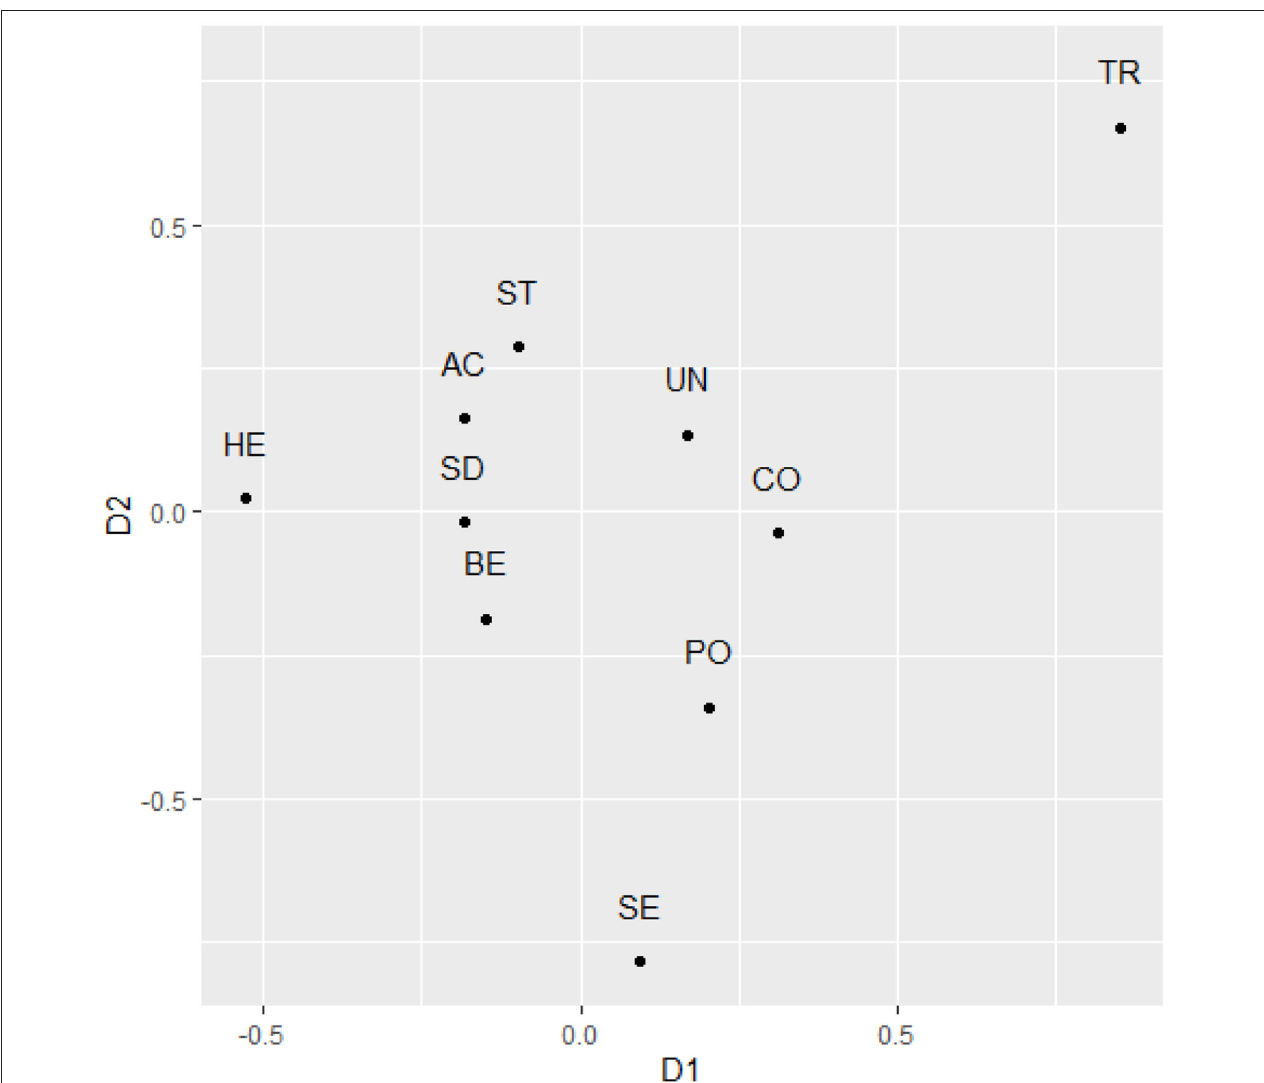
FIGURE 3 | The two-dimensional representation of raw text-based value scores after rotation to maximal similarity with theoretical predictions in Study 2. SD, Self direction; ST, Stimulation; HE, Hedonism; AC, Achievement; PO, Power; SE, Security; TR, Tradition; CO, Conformity; BE, Benevolence; UN,